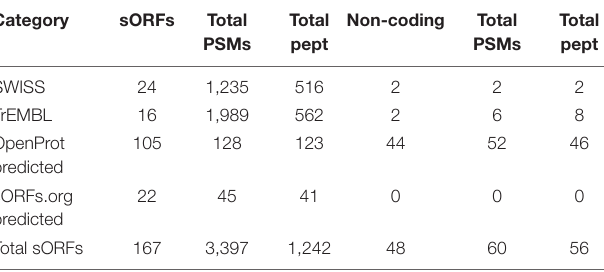
TABLE 1 | Overview general sORF identifications identified by the MS 2 ReScore approach.